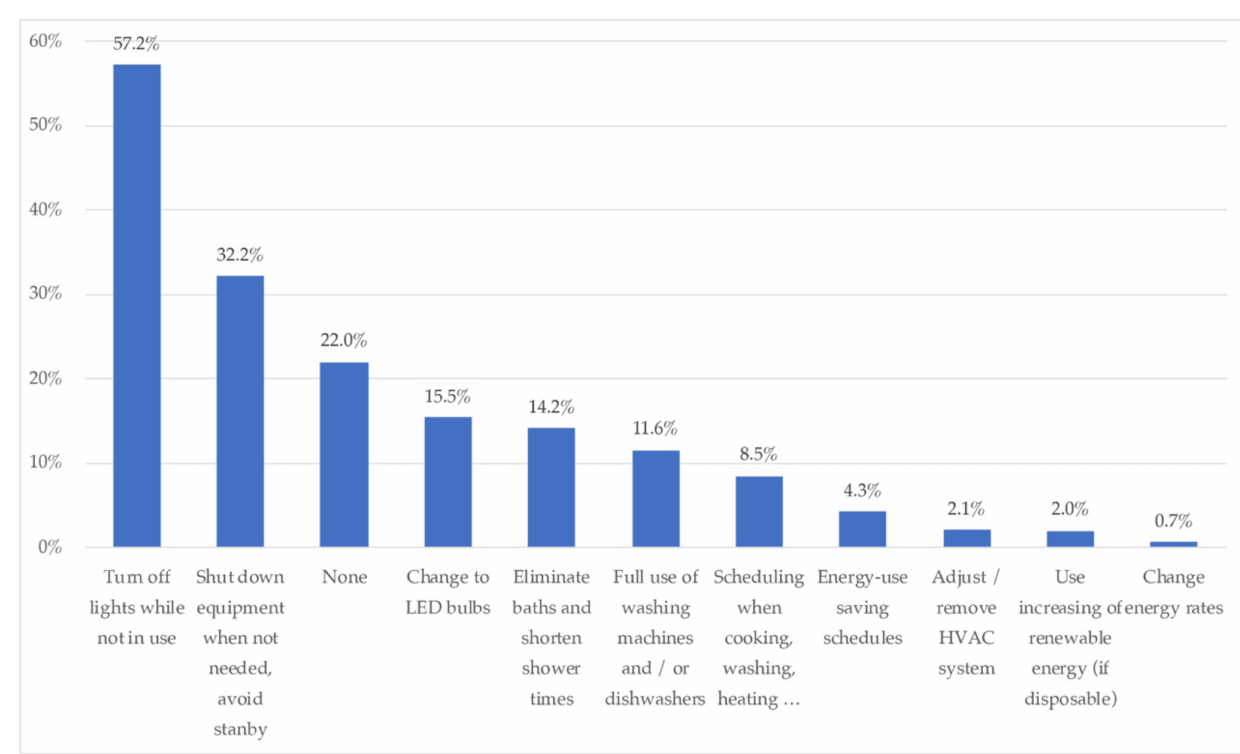
Figure 13. Energy saving strategies carried out in the households participating in the study